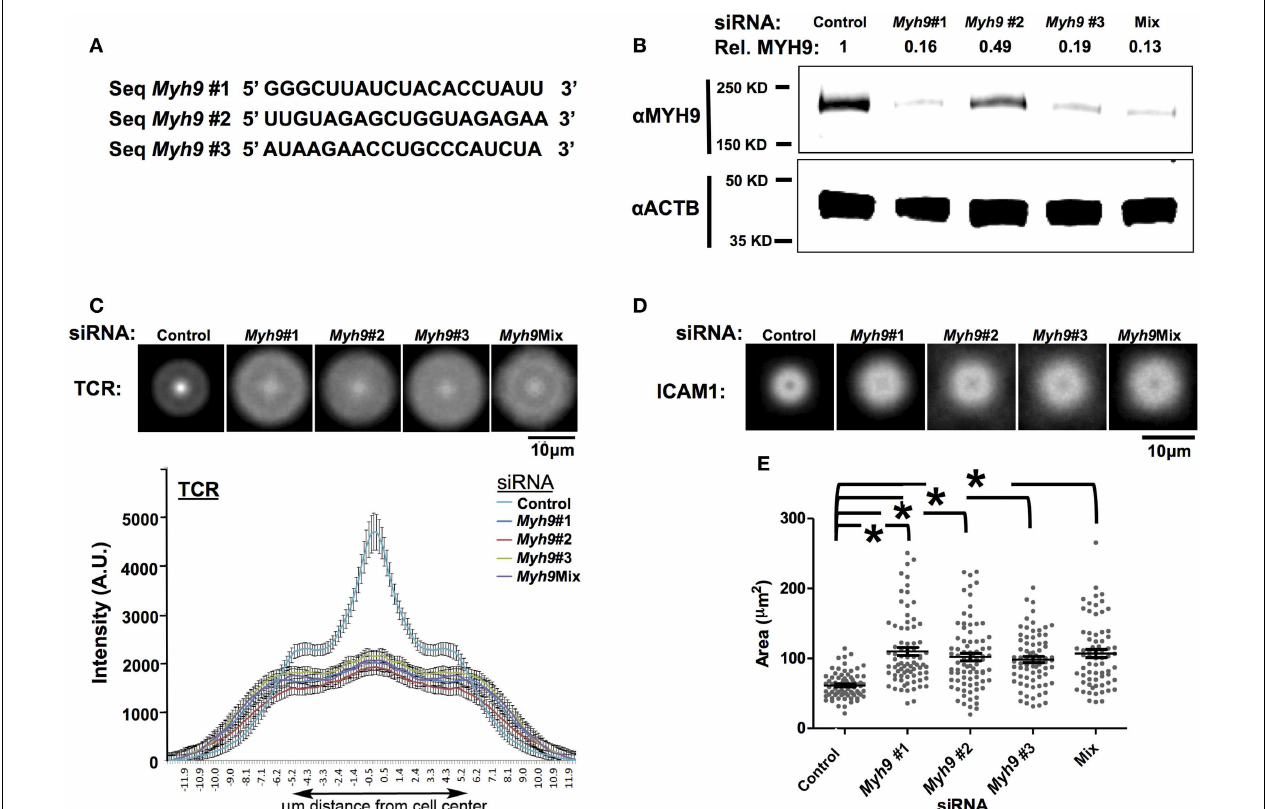
registered at the centroid for Alexa568-H57 staining ofTCR (C) or Cy5-ICAM-1 (D) .The plot in (C) shows diameter profiles ofTCR (Alexa568-H57 staining) distributions with standard error of the mean through the centroid in > 60 cells for each siRNA transfection. (E) T cell-bilayer contact area measured using interference reflection microcopy images. Each point on the plot represents the value for a single cell, and the bars represent mean values ± SEM.The mean values of contact areas are significantly higher in Myh9 siRNA-treated cells (#1–110.1, #2–102.0, #3–98.4, Mix-107.0 µ m 2 ) compared to control (61.47 µ m 2 ). * p -values < 0.0001 vs.